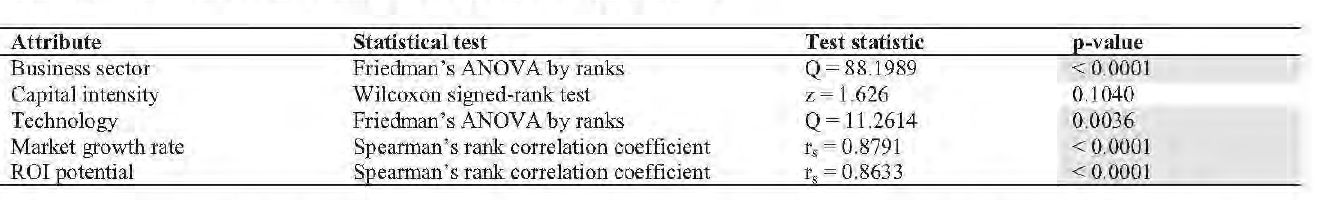
Table 3: Significance of attributes of entrepreneurial opportunities